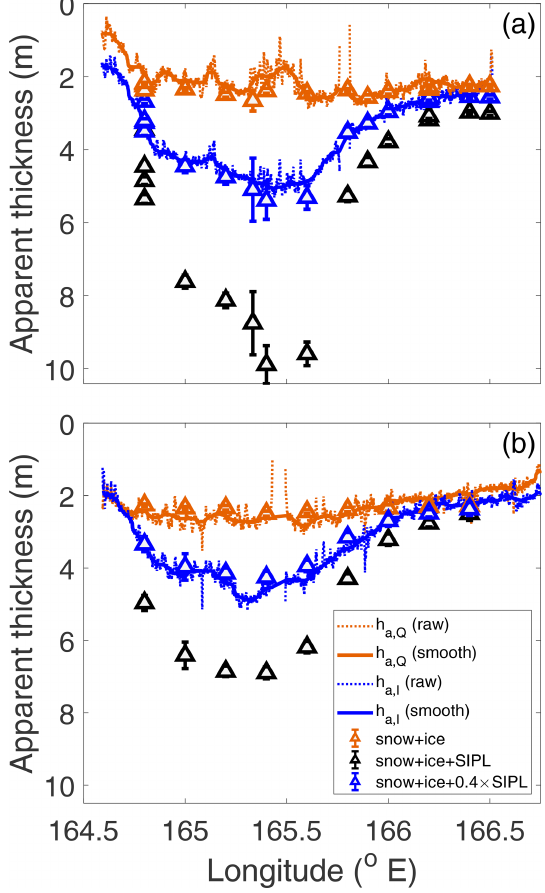
Figure 6. Apparent AEM thicknesses h a ,Q (orange lines) and h a ,I (blue lines) along E–W profiles at (a) 77 ◦ 50 (cid:48) S and (b) 77 ◦ 46 (cid:48) S in November 2011, approximately 3 and 11km from front of Mc- Murdo Ice Shelf, respectively. Dotted lines are raw data, while solid lines are filtered with a 300-point median filter. Triangles show mean and standard deviation of drill-hole measurements at cali- bration points. Consolidated ice (snow plus ice; orange), consol- idated ice plus SIPL thickness (black), and consolidated ice plus ( α = 0 . 4) × SIPL thickness (blue; Eq.